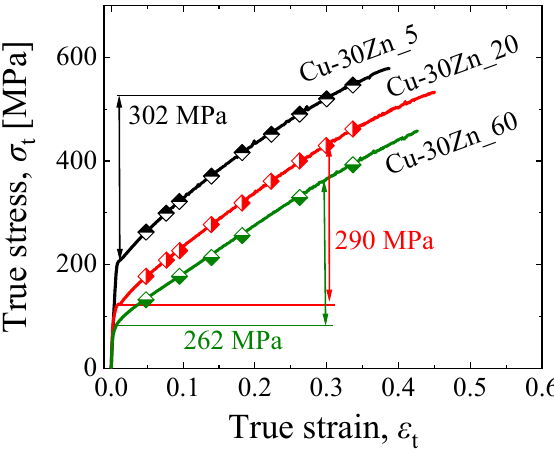
Figure 10. True stress–strain curves for Cu-30Zn_5, Cu-30Zn_20, and Cu-30Zn_60 [22]. Specimens were deformed at the strains denoted by each curve marks to conduct XRD measurements.